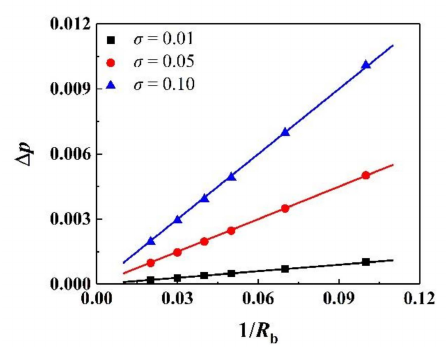
Figure 3. Relationship between pressure di ff erence, surface tension, and radius of the